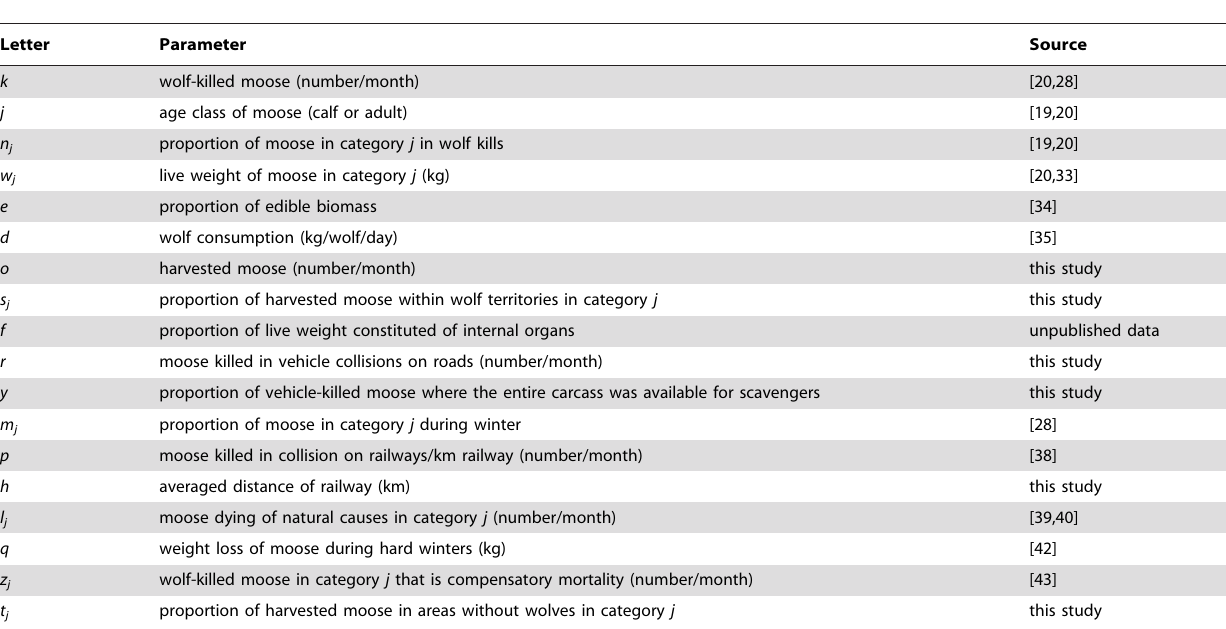
Table 1. Variable inputs used to estimate available biomass (kg/month) from moose killed by wolves, hunter harvest, vehicle collisions, and natural death within an area the size of an average annual wolf territory (900 km 2 ) in Scandinavia with and without presence of wolves.